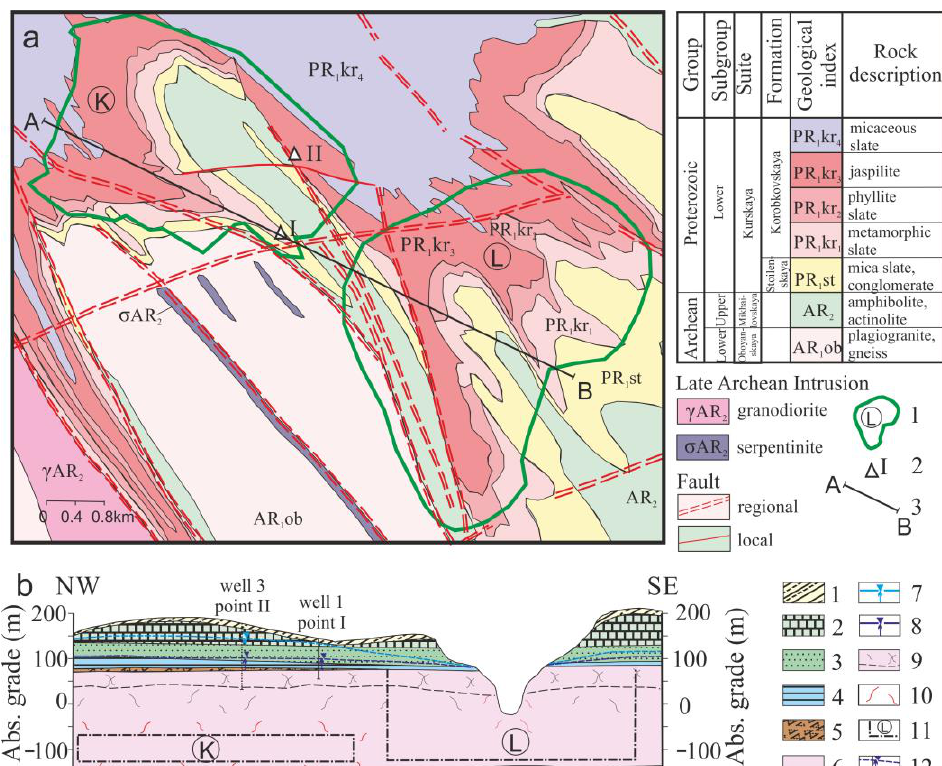
Figure 1. Geological map with stratigraphic classification ( a ) and cross section ( b ). (1–3a: 1— boundaries of iron ore deposits ( – Korobkovskoe, —Lebedinskoe); 2—observation points and their numbers (I and II); 3—the line of cross section; 1–12b: 1–6—deposits: 1—Quaternary, 2—Upper Cretaceous, 3—Lower Cretaceous,4—Jurassic, 5—Devonian, 6—Archean-Proterozoic; 7—the level of the upper aquifer; 8—level of the lower aquifer; 9—zone of exogenous fracturing (top) and systems of individual fractures (bottom); 10—technogenic fractures; 11—boundaries of iron ore deposits; 12‒well) (based on [ 30]).